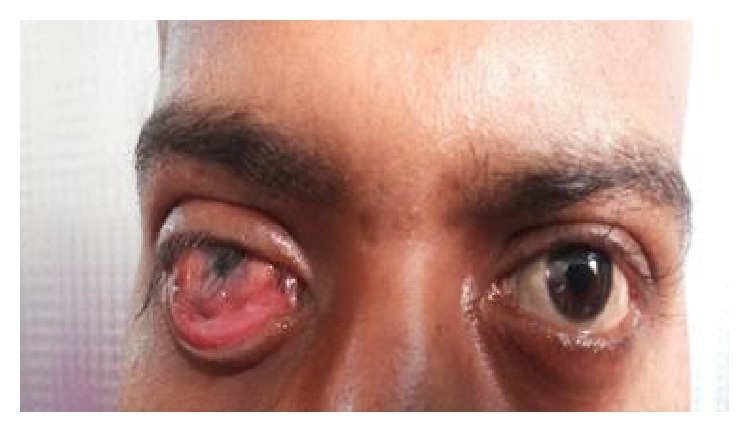
Pseudotumor—axial.